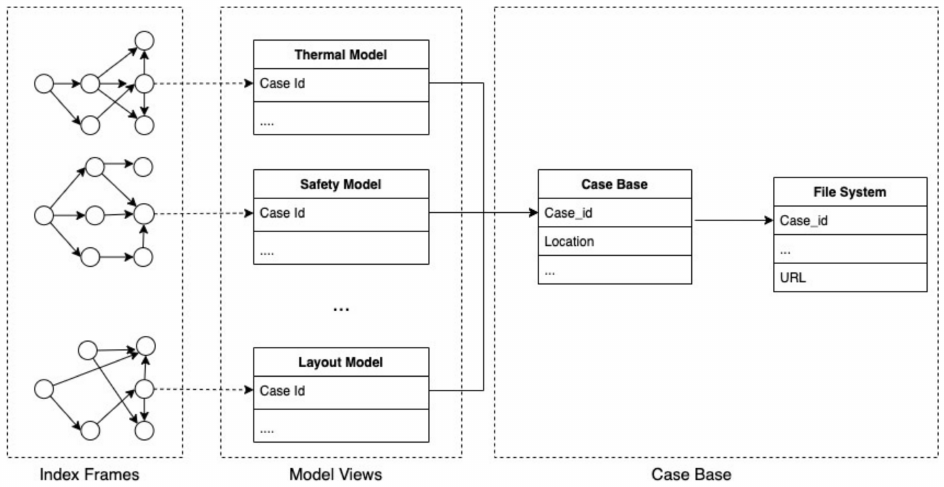
Figure 6. The conceptual schema of the case